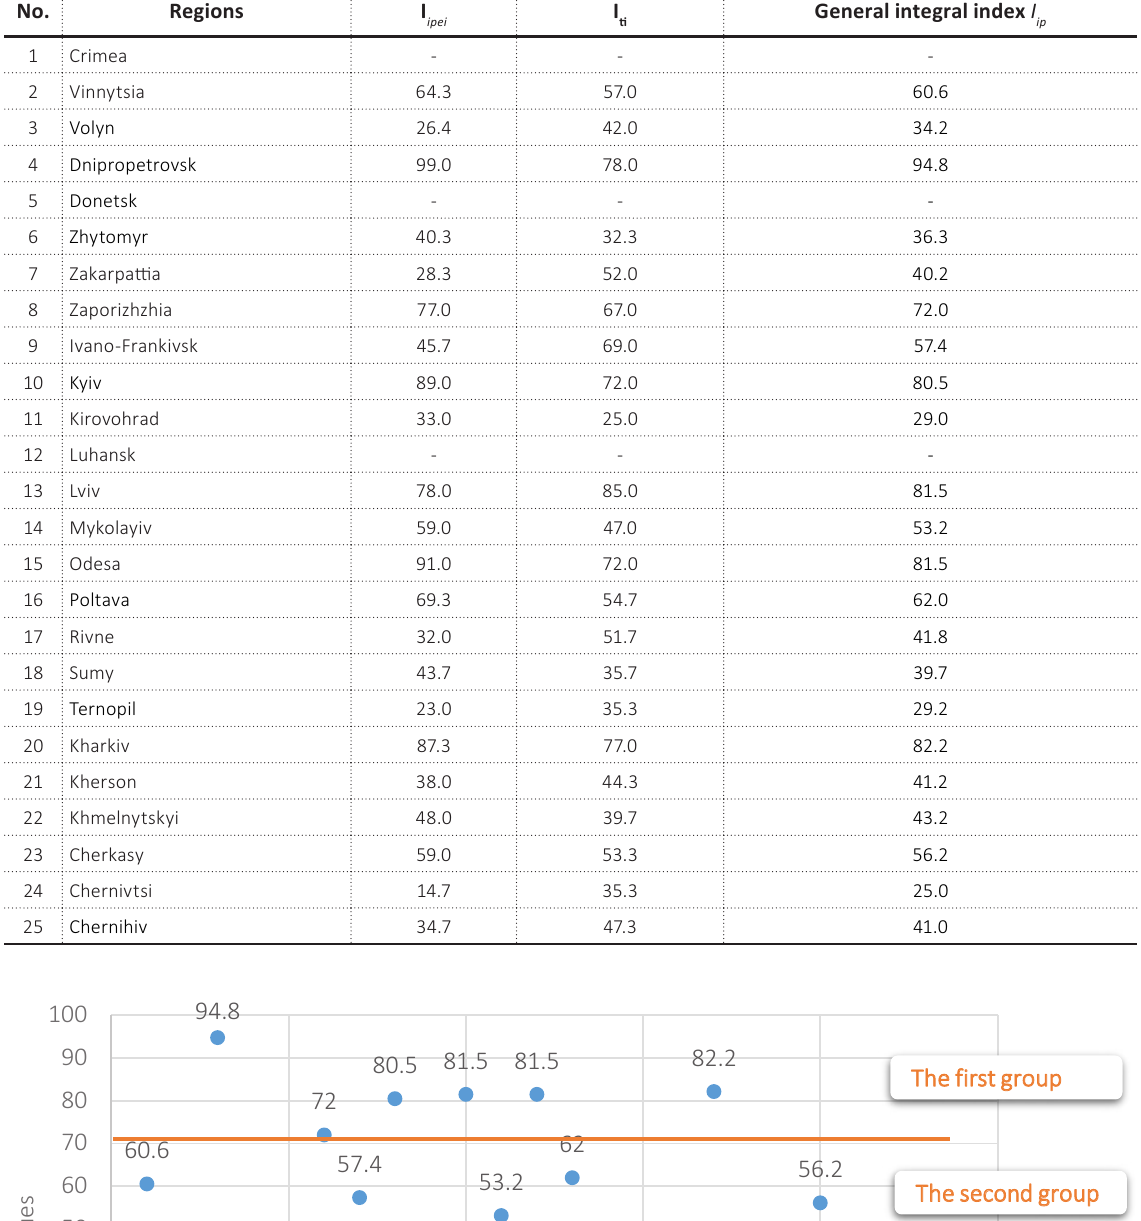
Table 1. Integrated index of investment potential of tourist systems in the regions of Ukraine